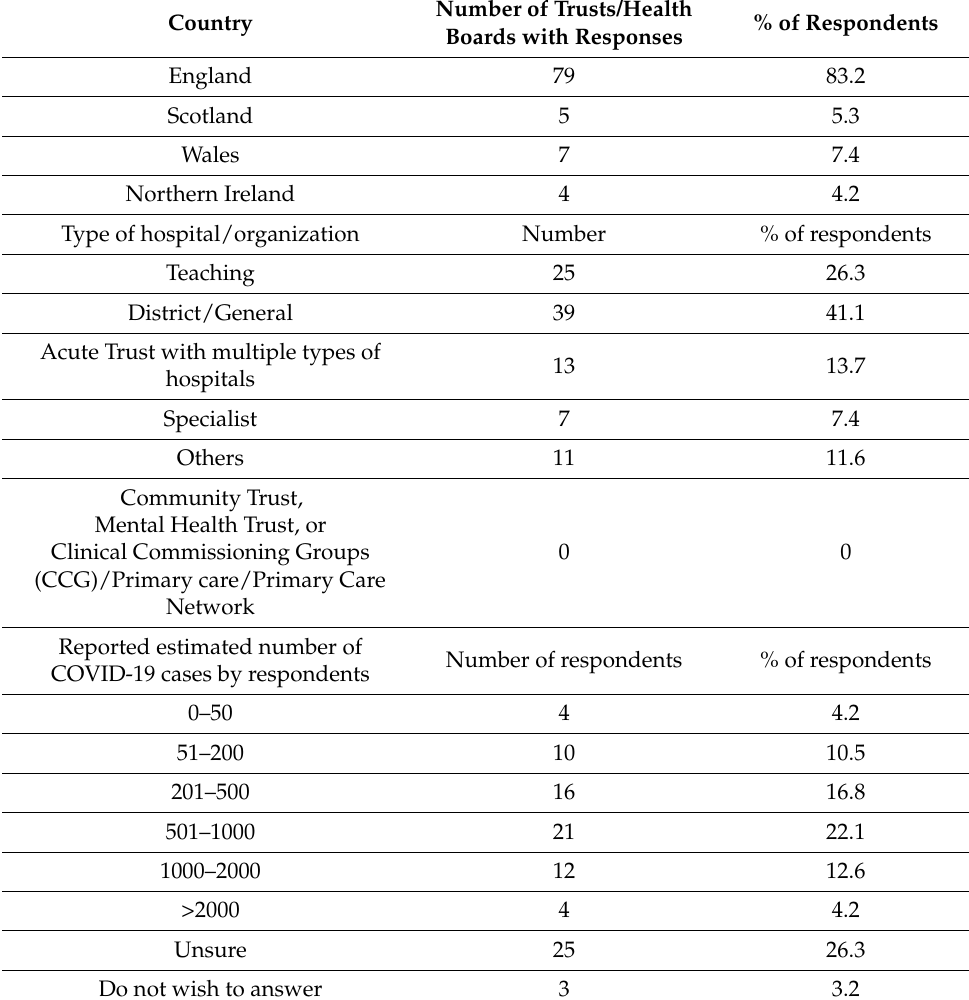
Table 1. Country distribution of responses ( n =